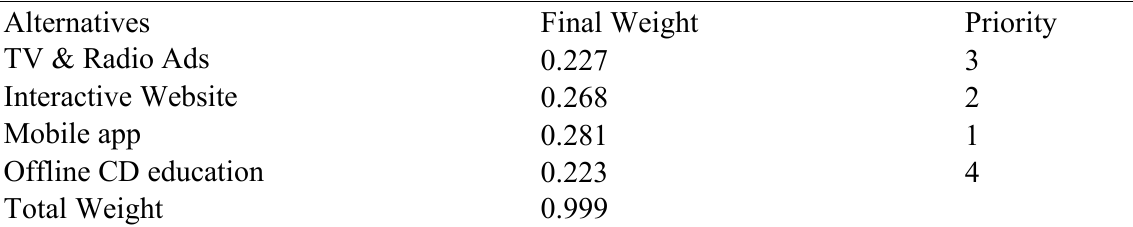
Table 4. Final options’